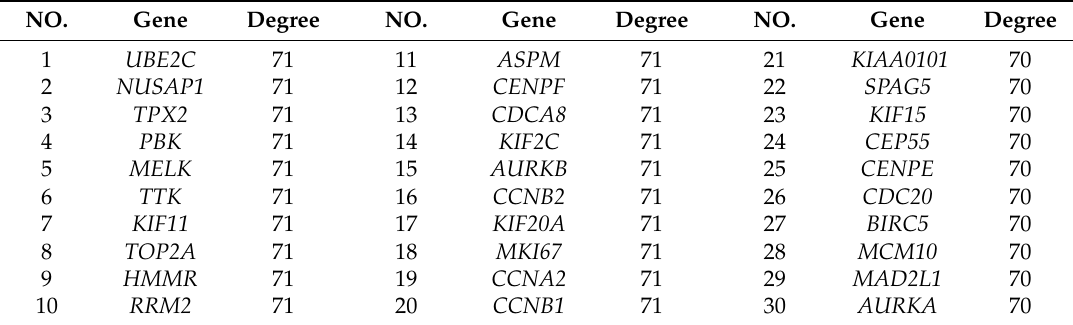
Table 2. Top 30 genes with highest degrees of connectivity in clustering module 1.